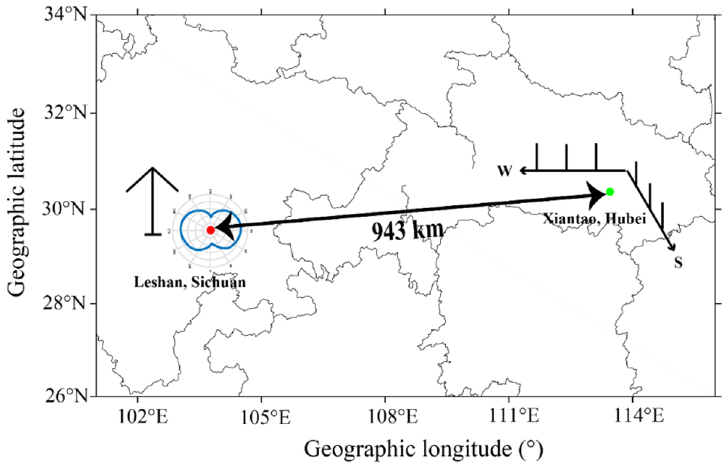
Figure 9. The geographical location diagram of the transceiver station.